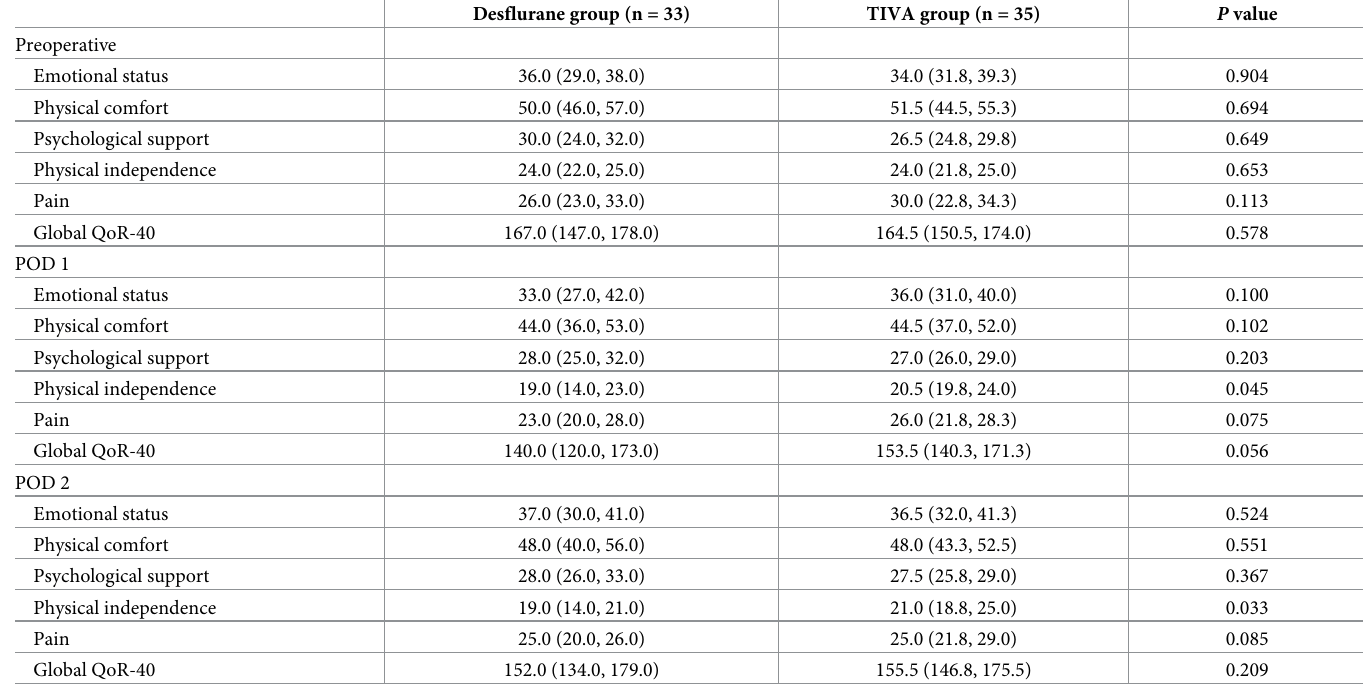
Table 2. QoR-40 scores preoperatively and on postoperative days 1 and 2.